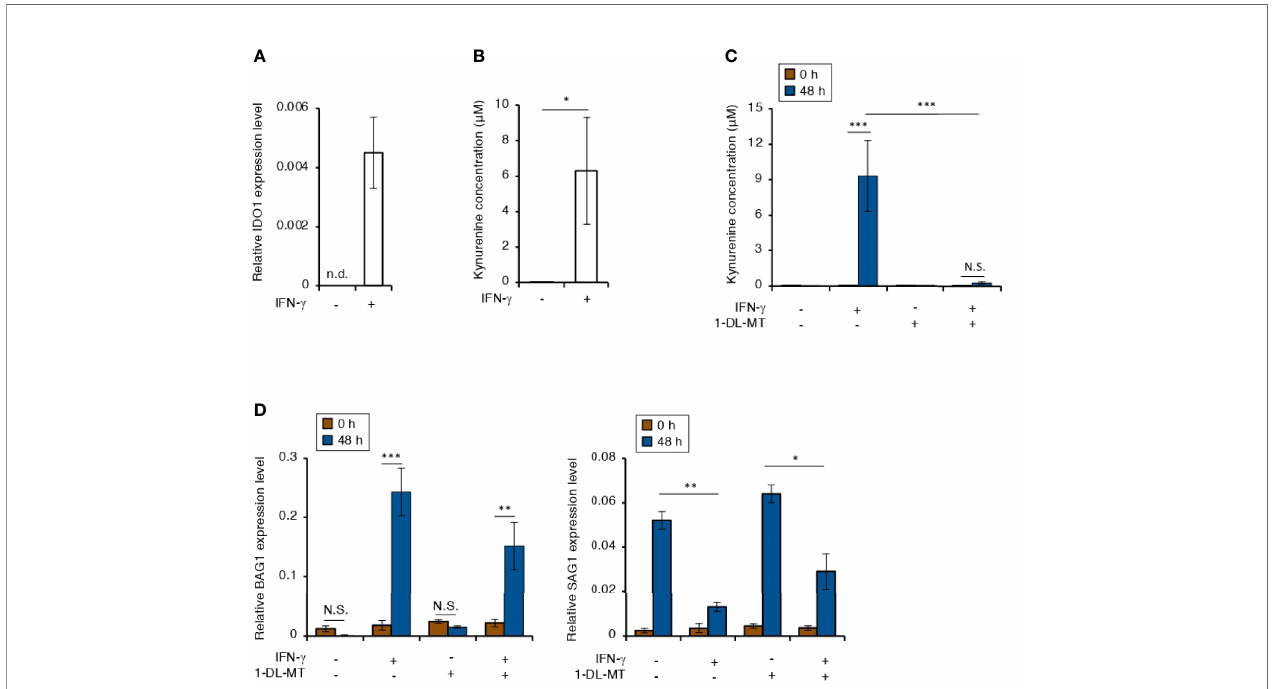
FIGURE 3 | Tryptophan degradation plays no role in the IFN- g -dependent T. gondii stage conversion in human neuroblastoma cells. (A) IMR-32 cells were untreated or treated with IFN- g and incubated for 24 h. The IDO1 mRNA level was analyzed by use of quantitative RT-PCR. (B) IMR-32 cells were untreated or treated with IFN- g and incubated for 48 h. The level of kynurenine released into the culture supernatant was measured by ELISA. (C) IMR-32 cells were untreated or treated with IFN- g and/or 1-DL-MT and incubated for 48 h. The level of kynurenine released into the culture supernatant was measured by ELISA. (D) IMR-32 cells infected with T. gondii ME49 were untreated or treated with IFN- g and/or 1-DL-MT and incubated for 0 or 48 h. Then, the BAG1 or SAG1 mRNA level was analyzed by use of quantitative RT-PCR. Values are means ± SD (three biological replicates per group from three independent experiments) (A – D) . * p < 0.05, ** p < 0.01, *** p < 0.001; N.S., not signi fi cant; Student ’ s t